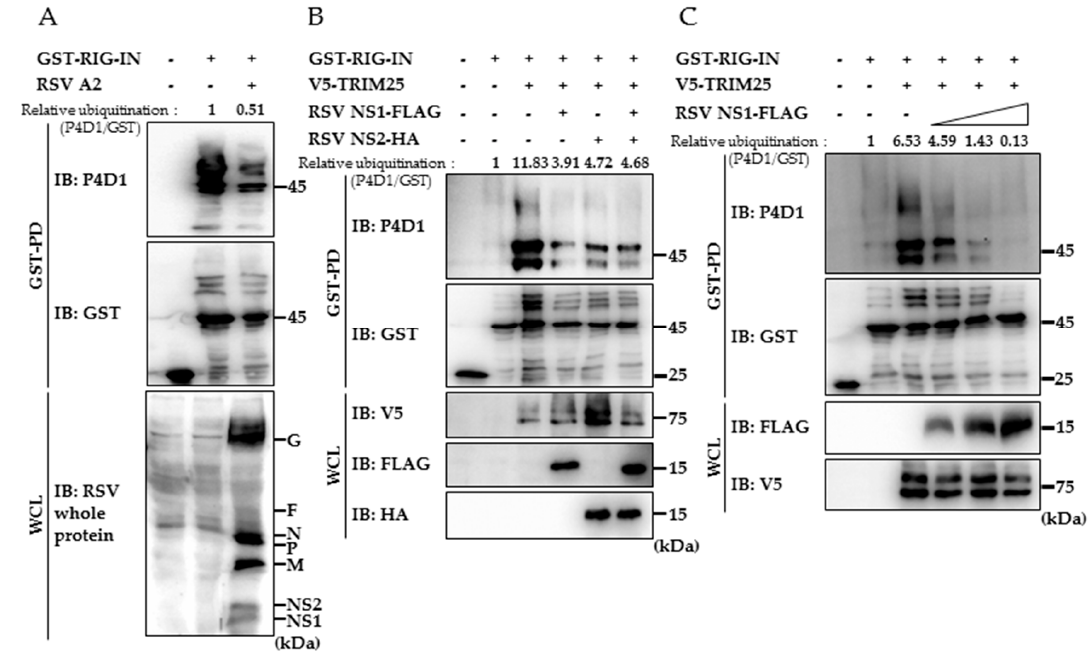
Figure 2. Inhibition of RIG-I ubiquitination by RSV NS1. ( A ) HEK293T cells were transfected with vector (pEBG-GST; 7 µ g/dish) or GST-RIG-I-2Cards (GST-RIG-IN; 10 µ g/dish) and incubated for 24 h. Cells were infected with RSV (m.o.i. = 4) as indicated and further incubated for 24 h. Cell lysates were subjected to GST-pulldown and immunoblotting using indicated antibodies to analyze the ubiquitination of GST-RIG-IN. Ubiquitinated forms were detected using anti-ubiquitin antibody (P4D1). ( B ) RSV NS1 and NS2 expression plasmids were transfected to HEK293T cells together with RIG-IN and TRIM25 as indicated. Cell lysates were subjected to GST-pulldown assays. Ubiquitination of RIG-IN was analyzed by immunoblotting of GST pulldown samples and whole cell lysates (WCL). ( C ) RIG-IN and TRIM25 were transfected with increasing amounts of RSV NS1. RIG-IN ubiquitination was analyzed as in ( B ). Ubiquitination of RIG-I was quantitatively analyzed by densitometry and normalized to pulled-down GST-RIG-IN (unubiquitinated form) of each sample. All experiments were conducted at least three times with similar results.